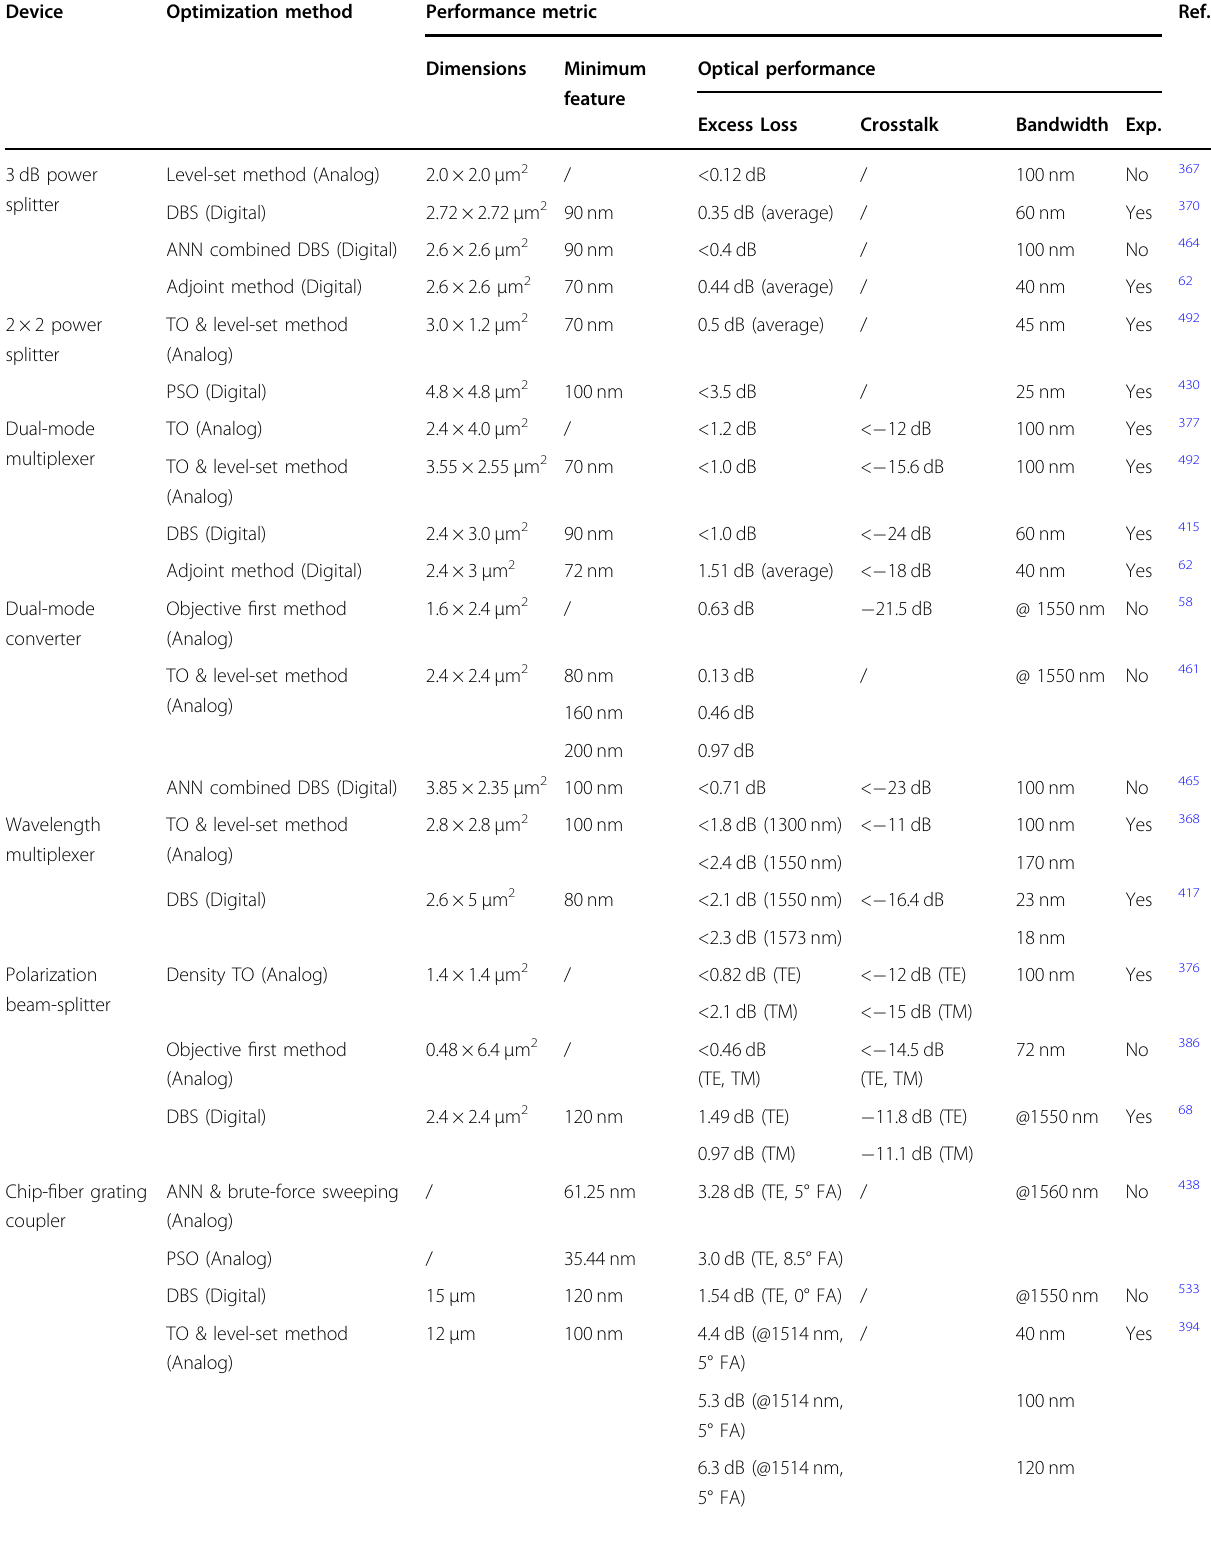
Table 1 Comparisons of different inverse-designed methods for meta-waveguides